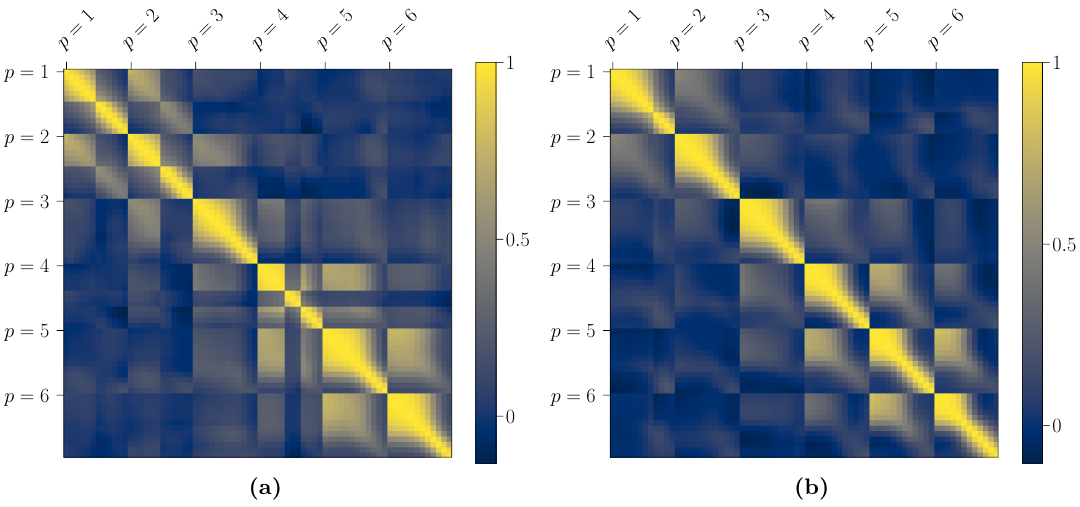
p Cov Cov . Within each lattice momentum block, entries ij / ii jj